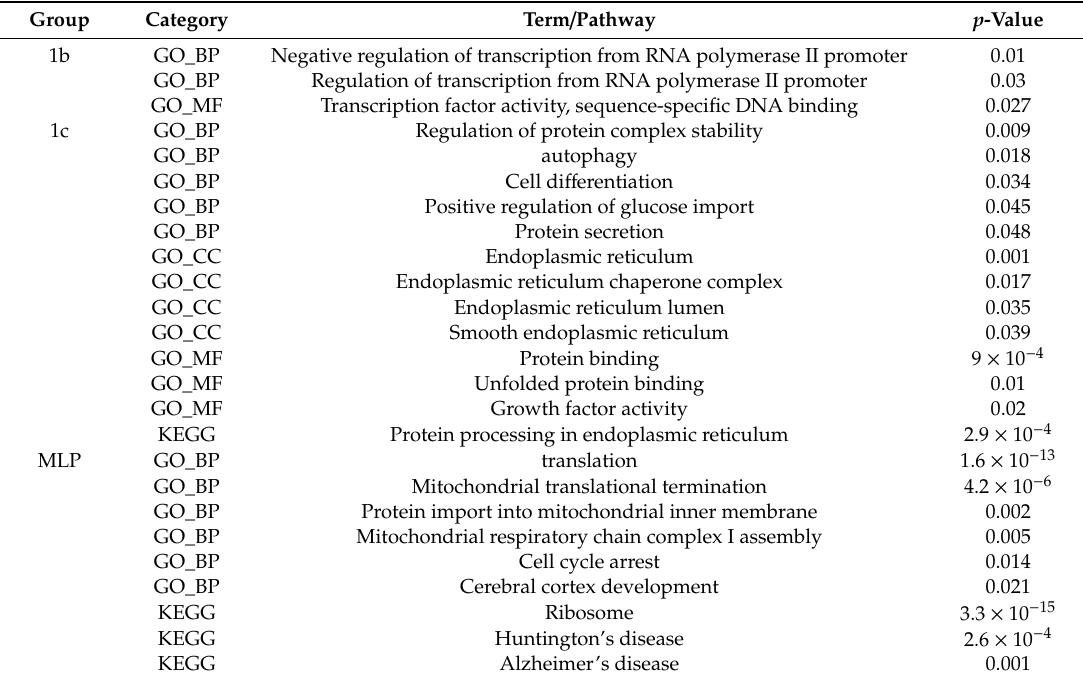
Table 1. Significantly enriched Gene Ontology (GO) and Kyoto Encyclopedia of Genes and Genomes (KEGG) terms / pathways identified by DAVID.